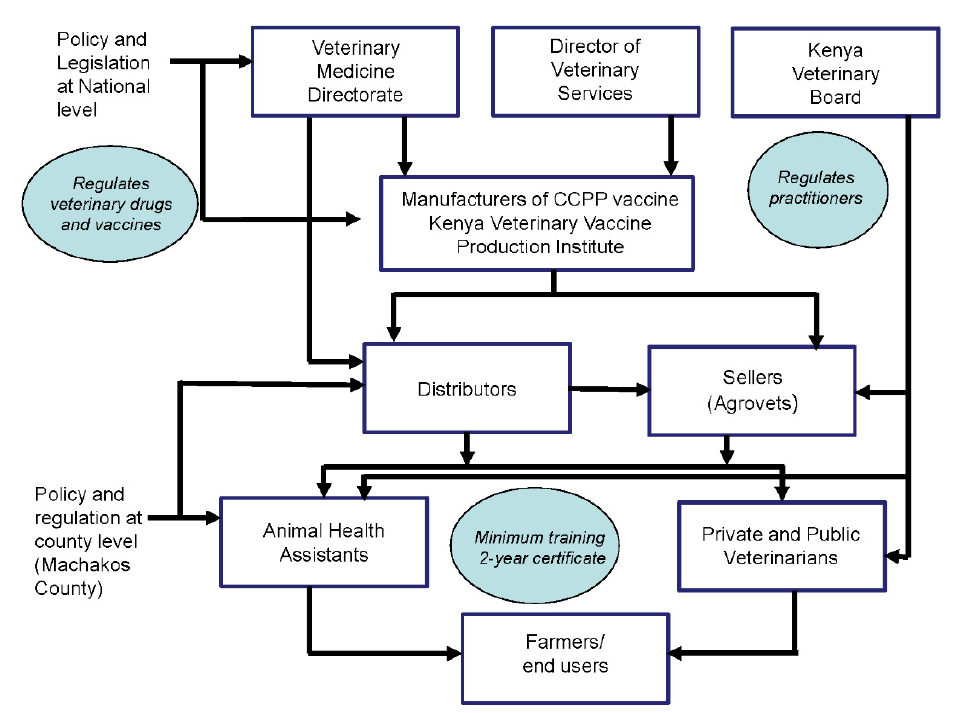
Figure 2. CCPP vaccine value chain showing legislation and distribution flow of vaccine from man- ufacturer to end